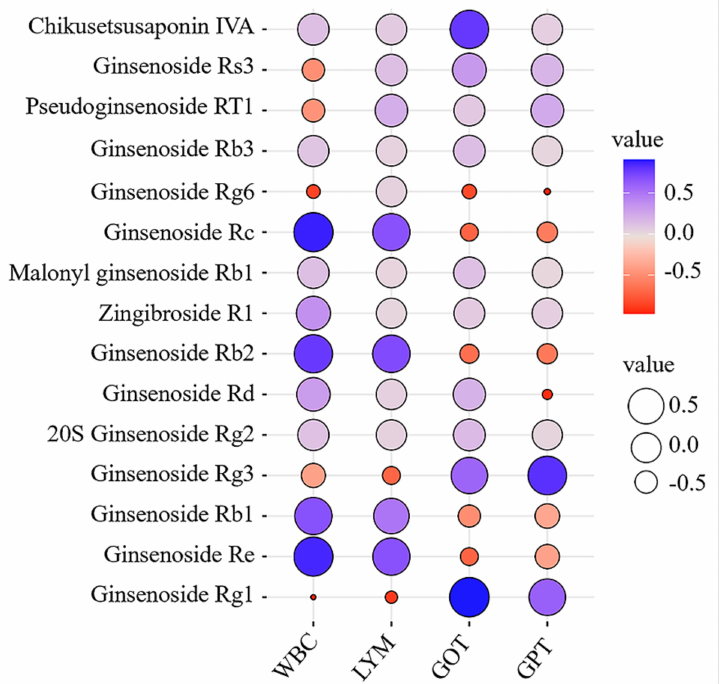
Figure 7. Bubble chart of Pearson correlation